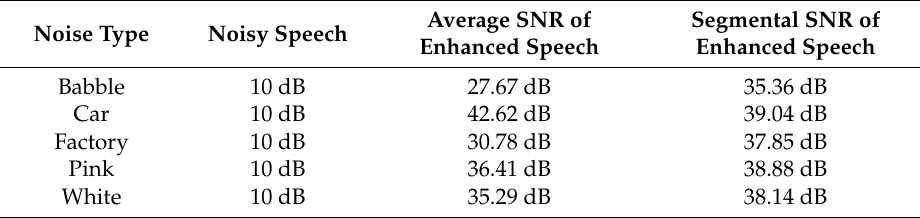
Table 3. Average values of SNR and segmental SNR of noisy speech (10 dB) and enhanced